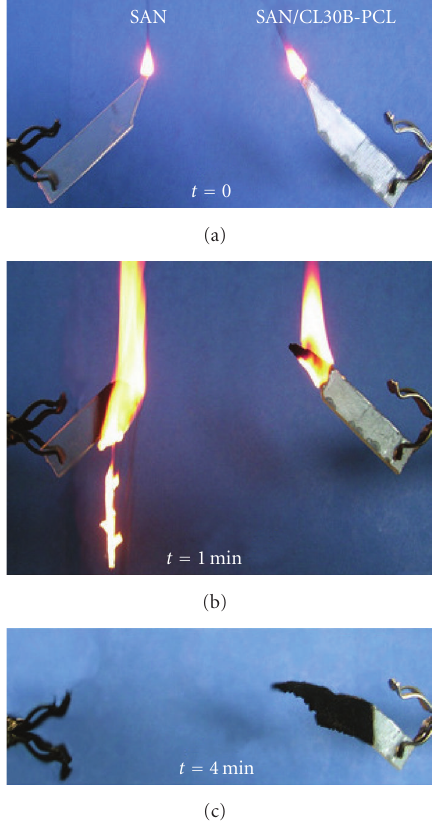
Figure 5: Qualitative flame test of SAN (on left) and SAN/CL30B- PCL (on right) with 0.05 wt% of Irganox MD1024 and 3wt% of inorganics. (Support information clips: http://mail.materianova .be/pub/supportinginformationbenalietal.wmv).